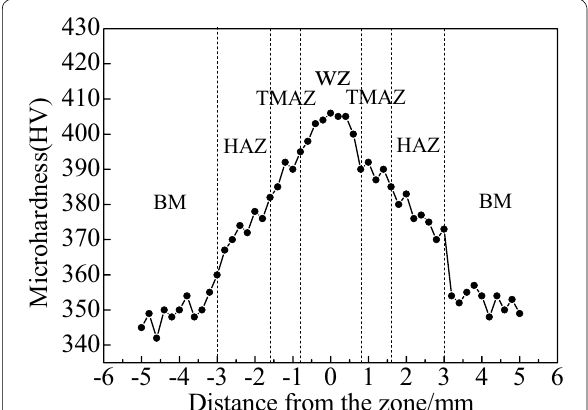
Figure 12 Microhardness profiles of the joint from weld zone to base metal